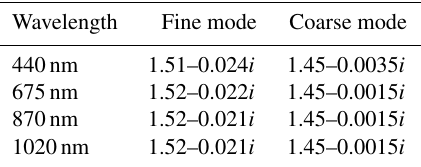
Table 1. Spectral complex refractive index for the smoke aerosol optical model used in this study, following Sayer et al.